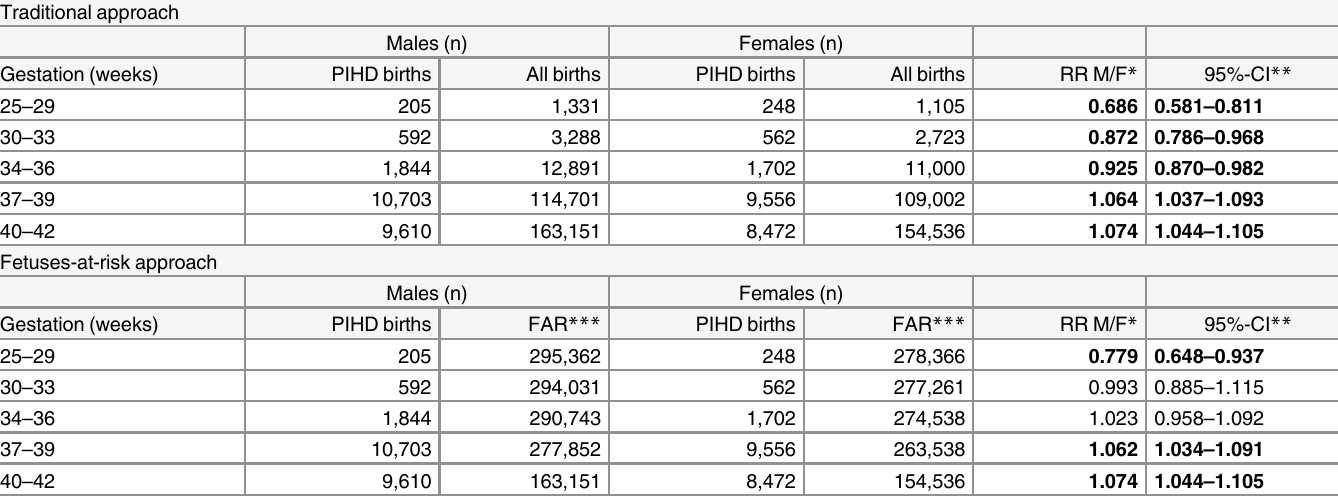
Table 6. Sexual dimorphism for PIHD by length of gestation in